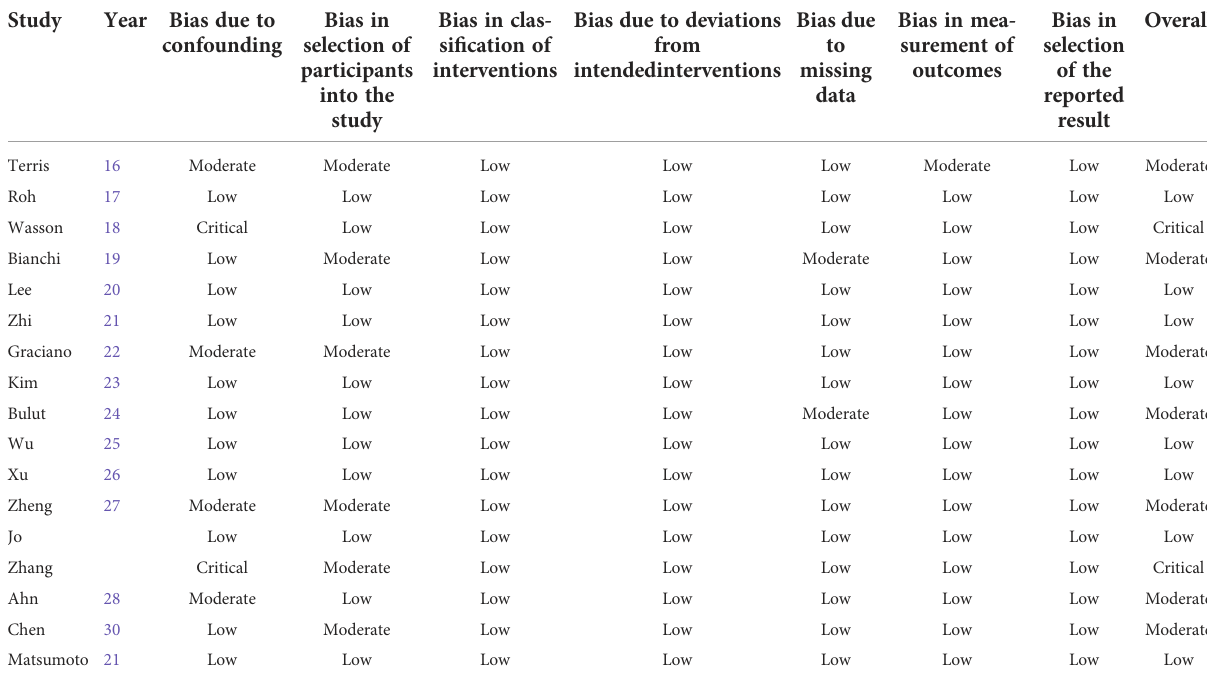
TABLE 2 Risk of bias assessment in cohort studies by ROBINS-I.